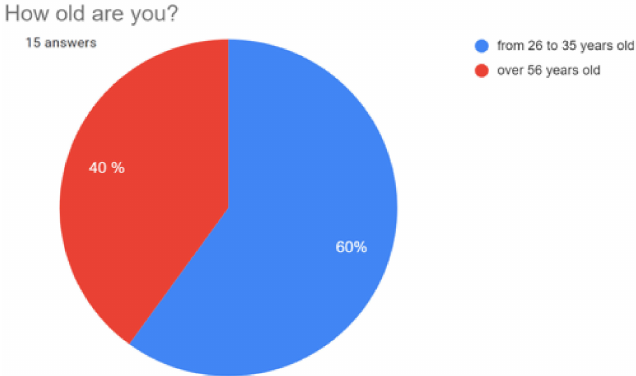
Figure 10. Profile of the sample of construction engineers.